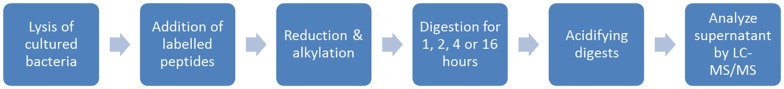
Schematic overview of the LC-MS/MS pre-treatment used in this study.